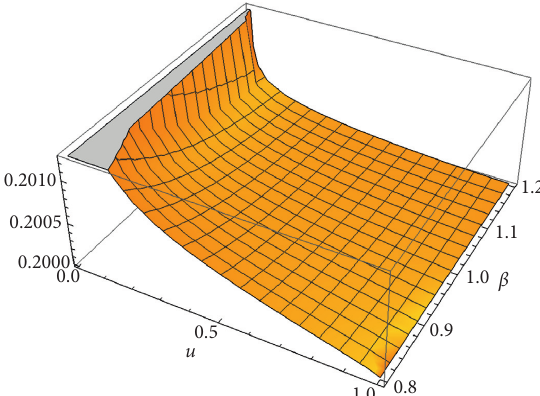
( x ) − F ( x ) , for all x � − ln u and u ∈ ( 0 , 1 ] e − Y 3 : 3 e − Y ∗ 3 : 3